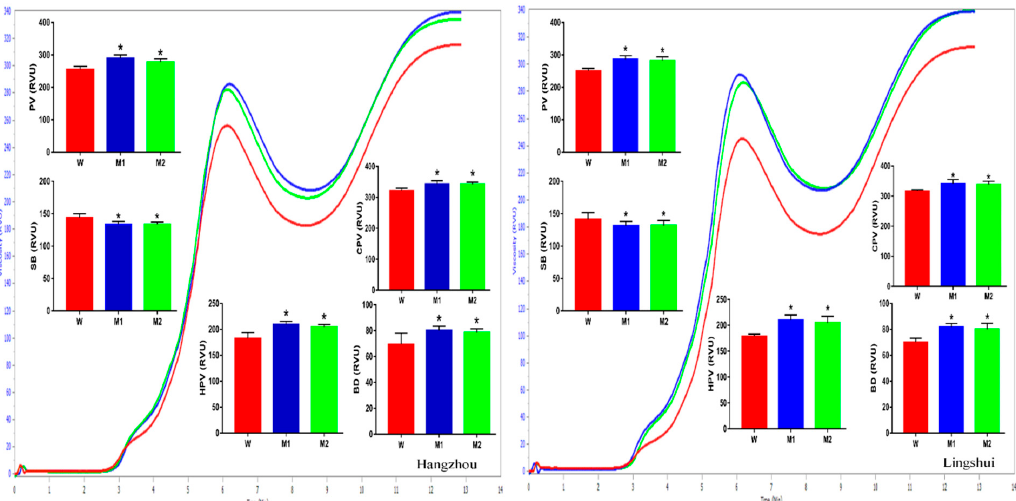
Figure 3. Pasting properties of brown rice of ospld α 1-1 (M1) and ospld α 1-2 (M2) mutants along with their wild-type Xidao#1 (W) harvested from plants grown at Hangzhou, Zhejiang and Lingshui, Hainan. The displayed data comprises the mean of three biological repeats and data significantly different from the wild type are shown by asterisk(s) (Duncan’s test, * p < 0.05).